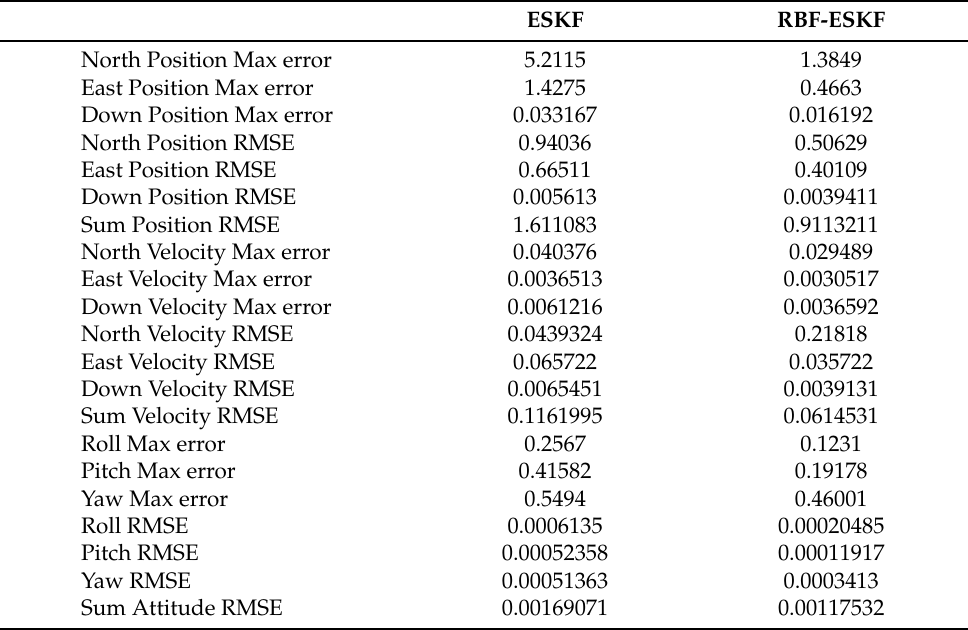
Table 4. Performance Comparison of ESKF and RBF-ESKF with loss of acoustic fix for a short period by running 100 Monte Carlo